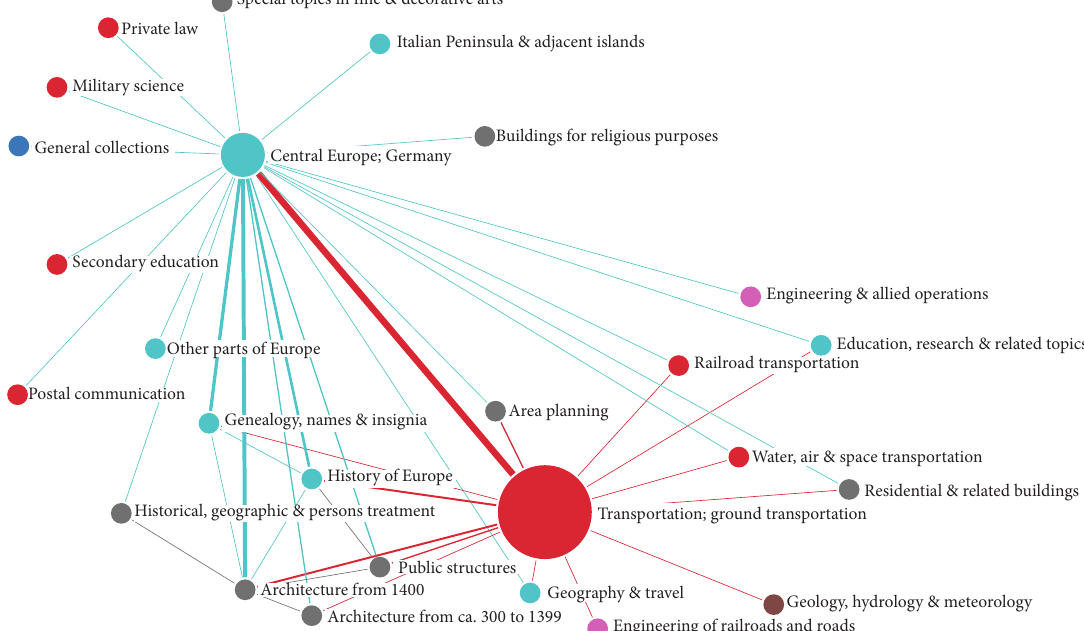
Figure 4: Visualization of a segment of the TTN of the city wiki Dresden (http://www.stadtwikidd.de/wiki/Hauptseite) using the 3rd level of the DDC as the underlying RCS for the definition of topics according to Section 3.2. The segment shows the highest weighted topics and their (undirected) links. Edges have been colored to show the two centers of this